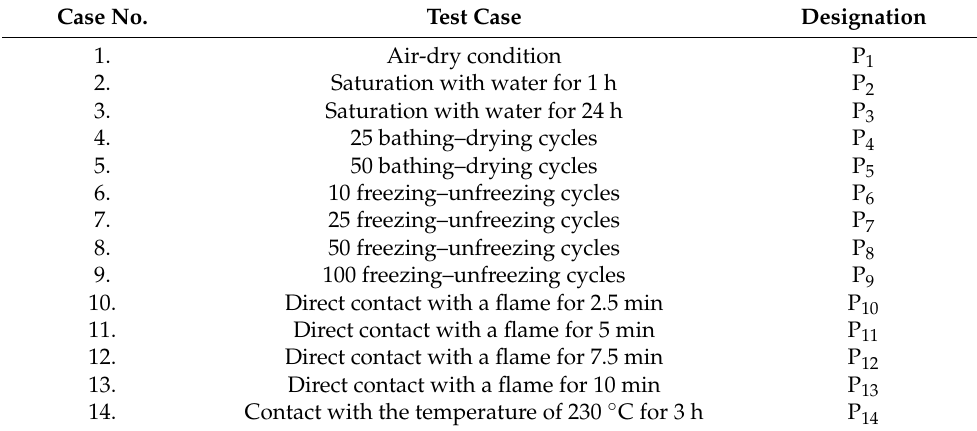
Table 2. Table of research cases of cellulose–cement composites with the adopted sample designation. Case No. Test Case Designation 1. Air-dry condition P 1